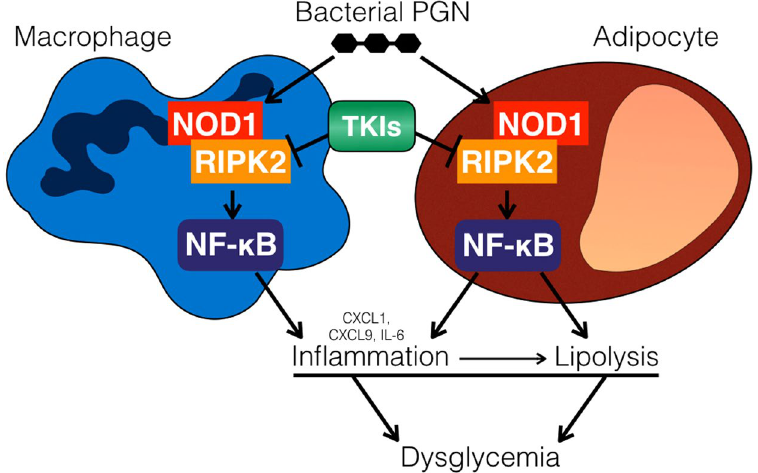
Figure 8. Inflammatory and metabolic effects of TKIs that inhibit RIPK2 in adipocytes and macrophages. RIPK2 is required for increased inflammatory cytokine production and lipolysis induced by bacterial peptidoglycan that acts on NOD1. Certain tyrosine kinase inhibitors (TKIs) inhibit RIPK2 in both macrophages and adipocytes thereby suppressing lipolysis, reducing inflammation and attenuating poor glucose control (dysglycemia) caused by bacterial cell wall